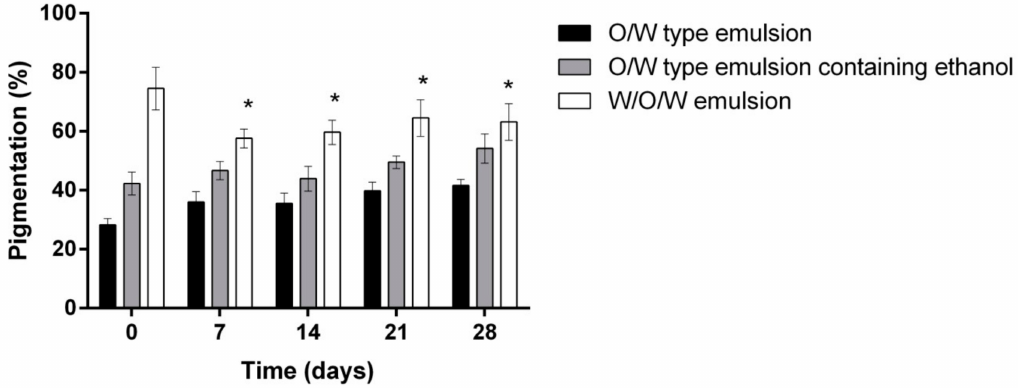
Figure 6. The influence of the investigated emulsions on the skin pigmentation * p < 0.01 vs. 0 days. N = 42